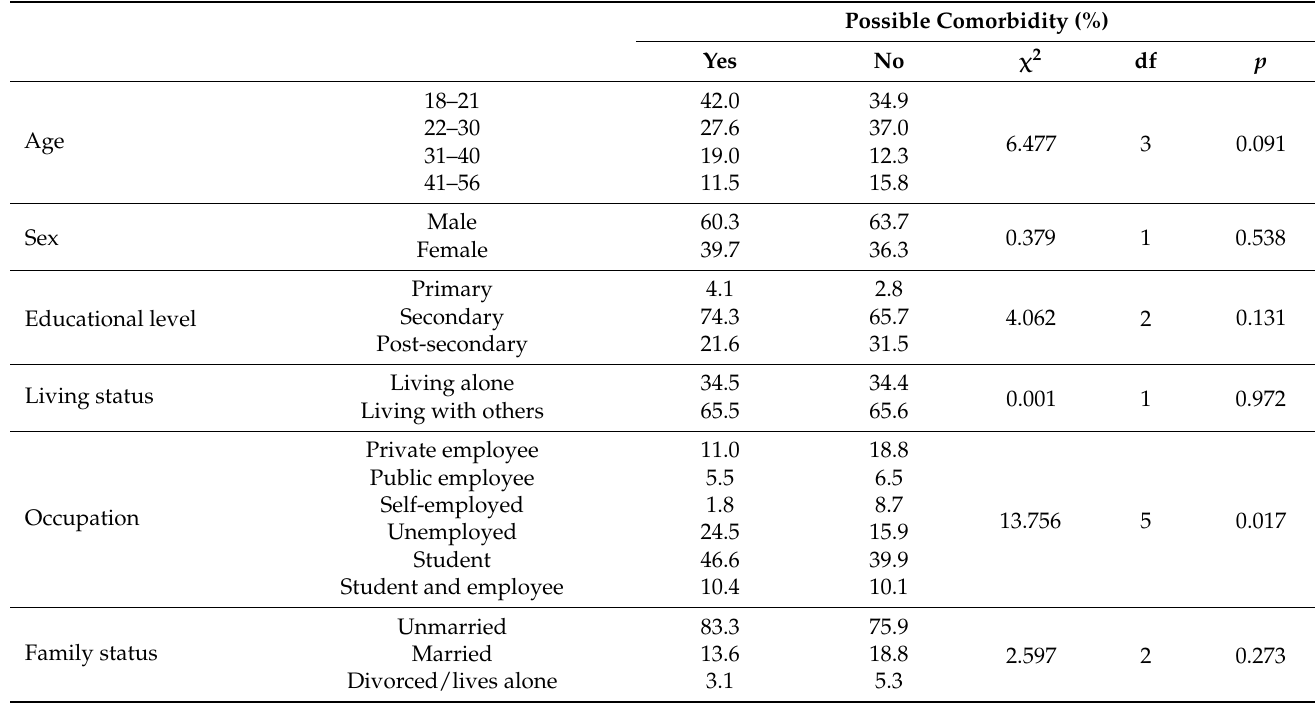
Table A5. Relationship of the Possible comorbidity of the assessed adults with the other variables.